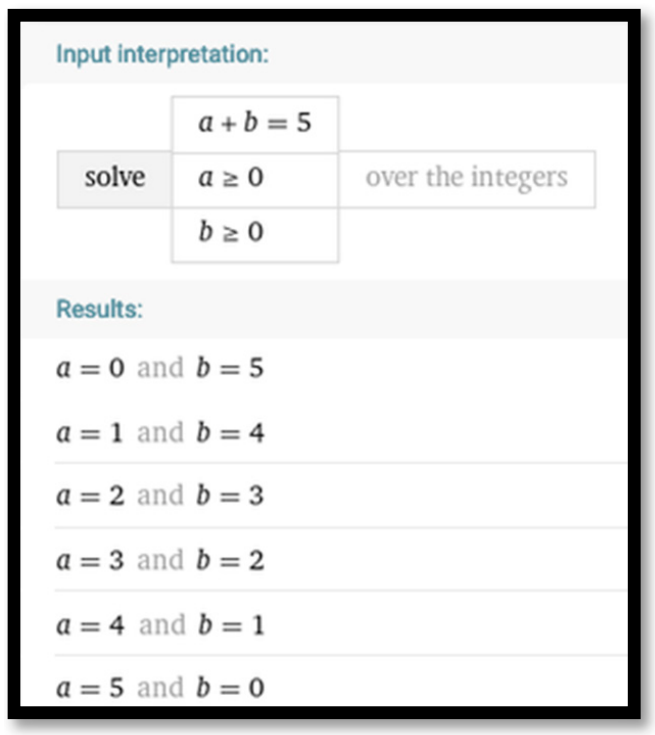
Figure 5. Approaching the problem